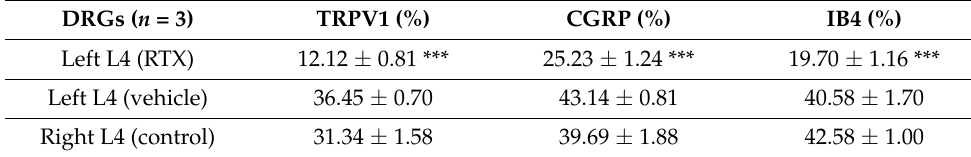
Table 3. The percentage distribution of nociceptive markers in the DRGs after 14 days of intraplantar injection of RTX (0.002%) or vehicle in the skin of the left hind paw of rats. A significant decrease in the number of TRPV1, CGRP and IB4 immunoreactive neurons were observed in the ipsilateral L4 DRG compared with L4 vehicle or control contralateral right L4 DRGs. No significant difference was observed in the number of these nociceptive markers between vehicle-injected L4 and control